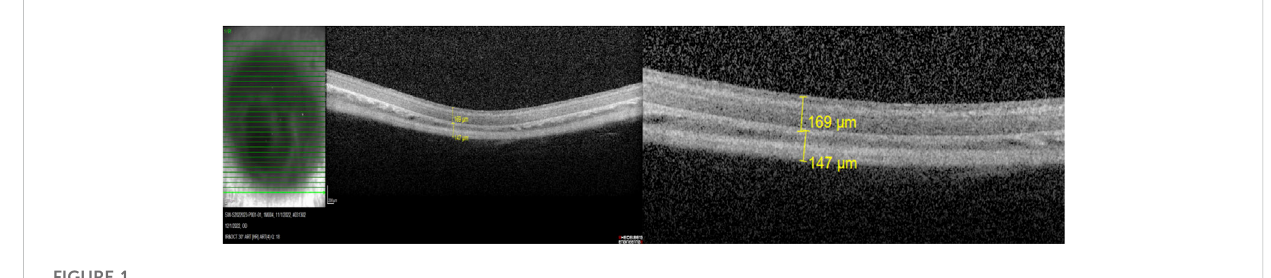
FIGURE 1 Structure of retina and choroid under